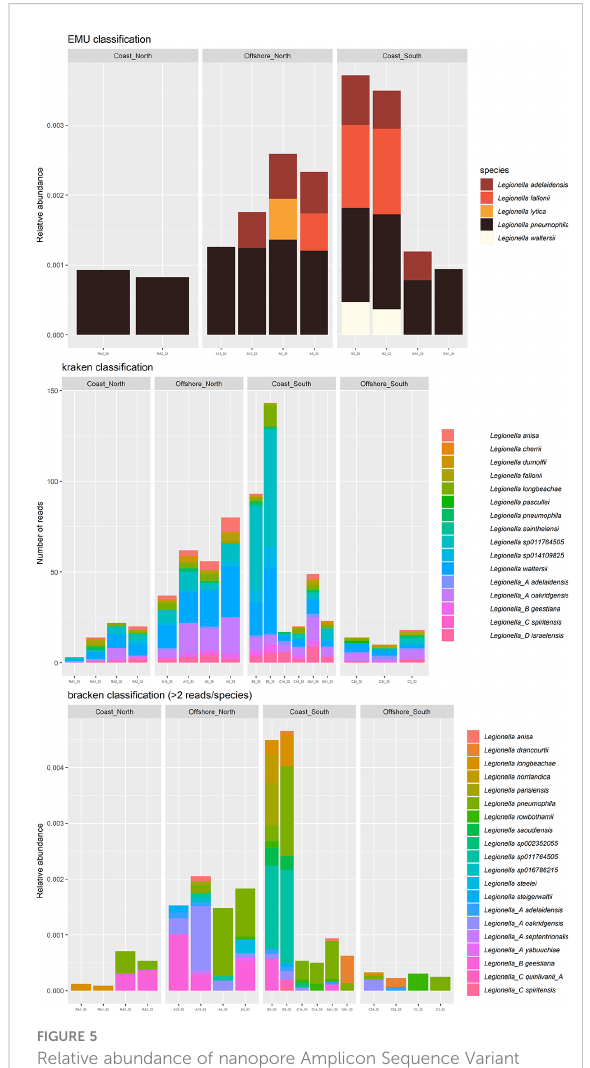
FIGURE 5 Relative abundance of nanopore Amplicon Sequence Variant reads (ASV) of genera Legionella at each station, assigned by classi fi cation algorithm EMU (top), kraken (middle) and bracken (bottom). Each sample was sequenced twice, after 30 and 33 PCR